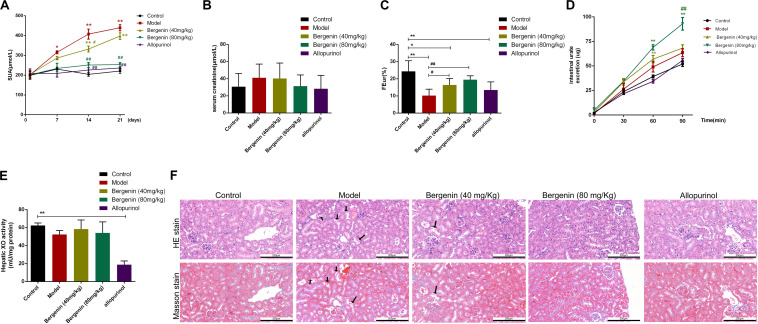
Effects of bergenin on hyperuricemia in mice treated with PO and YP. (A–E) Serum uric acid (SUA) levels (A), serum creatinine levels (Scr; n = 10) (B), fractional excretion of urate (FEur) (n = 6) (C), time course of intestinal urate excretion (n = 3) (D), and hepatic xanthine oxidase (XO) activity (E) in the different groups. Data are presented as mean ± SEM. *P < 0.05 and **P < 0.01, compared to the control group; #P < 0.05 and ##P < 0.01, compared to the model group. (F) Histopathological analysis of kidney tissues after H&E and Masson’s staining (magnification, ×200). Scale bar = 200 μm Degeneration and necrosis in renal tubular epithelial cells are indicated by black arrows.